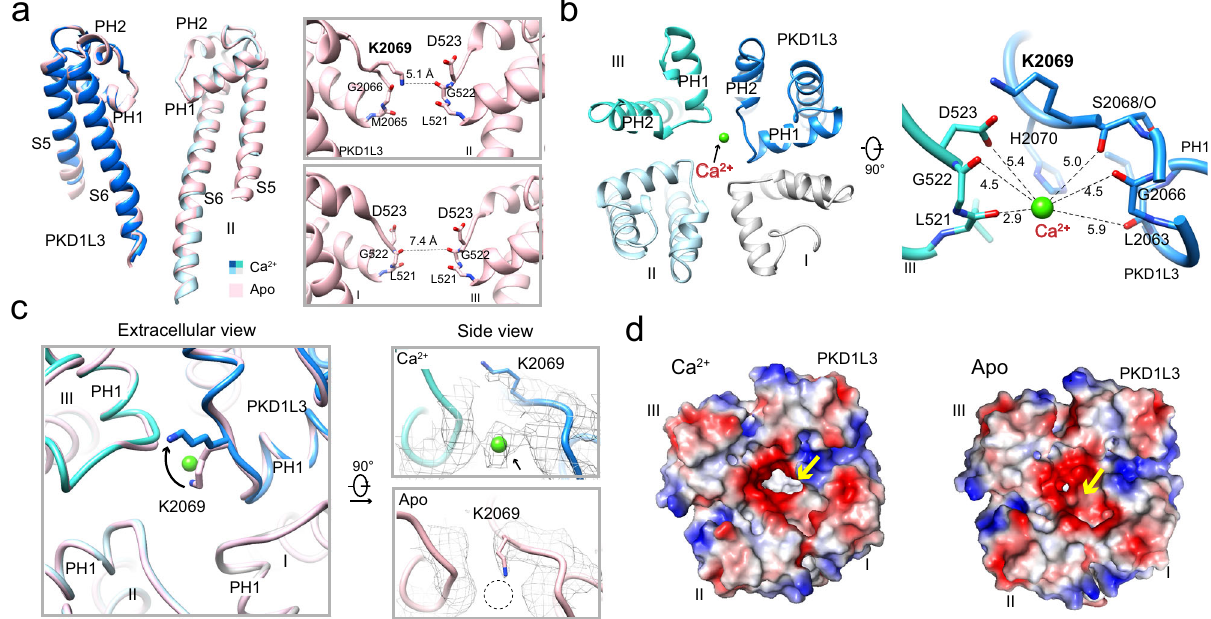
Fig. 3 A Lys switch for Ca 2 + entrance to the “ KDDD ” selectivity fi lter (SF). a An asymmetric SF. Left: The pore domain of the apo and Ca 2 + -loaded complexes exhibits nearly identical overall conformation. Right: The distinct composition of the SF segments in PKD1L3 and PKD2L1 results in an asymmetric SF in the heterotetramer. Shown in the insets are the side views of the SF in the two diagonal subunits of the apo structure. b A Ca 2 + ion is found in the SF in the Ca 2 + -loaded structure. Left: Ca 2 + is positioned off the central axis and closer to PKD1L3. Shown here is an extracellular view of the PD. Right: The bound Ca 2 + ion is mainly coordinated by three carbonyl oxygen groups on the SF loop of PKD1L3. The carboxylate group of Asp523 and two carbonyl oxygens from the two preceding residues in PKD2L3-III may also contribute to water-mediated coordination. The distances are indicated as black dashed lines and labeled in unit Å. c The upper site of the SF is open for Ca 2 + entry with an outward swing of the long side chain of Lys2069. Left: Distinct conformations of Lys2069 between the apo (pink) and the Ca 2 + -loaded (domain colored) structures. Right: The Ca 2 + was clearly resolved in the map of Ca 2 + -loaded complex. The densities, shown as gray mesh, are contoured at 4 σ . d An enlarged outer mouth and redistributed surface charges of the SF upon addition of Ca 2 + . Shown here are extracellular views of the electrostatic surface potential of the PD calculated in PyMol 70 Asn313 at PMD PKD1L3 and PMD III , respectively. However, Arg343 points into the interior of VSD I and VSD II likely owing